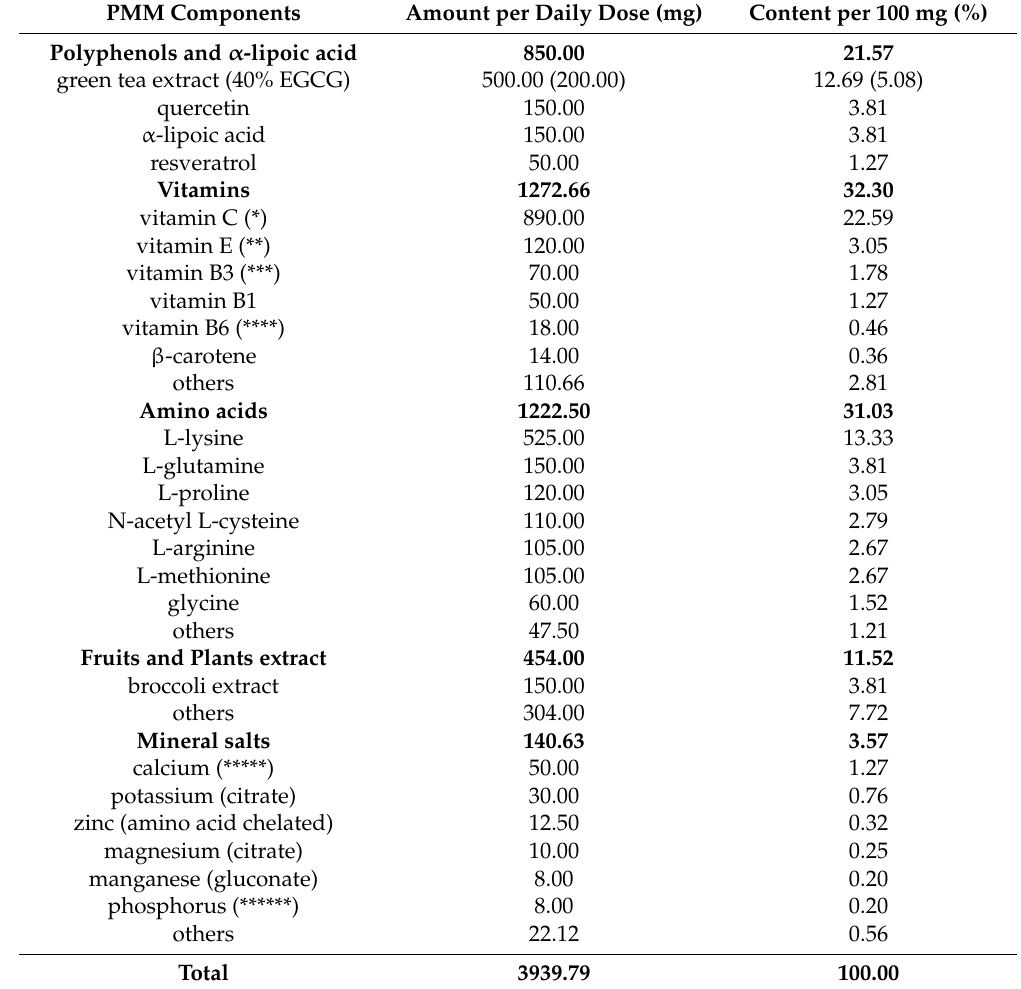
Table 1. Polyphenol-enriched micronutrient mixture (PMM)